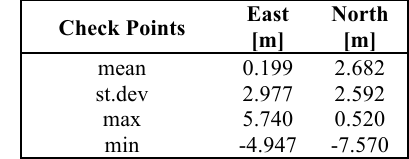
Table 4. Shift analysis - 20 points - parameters: scientific software